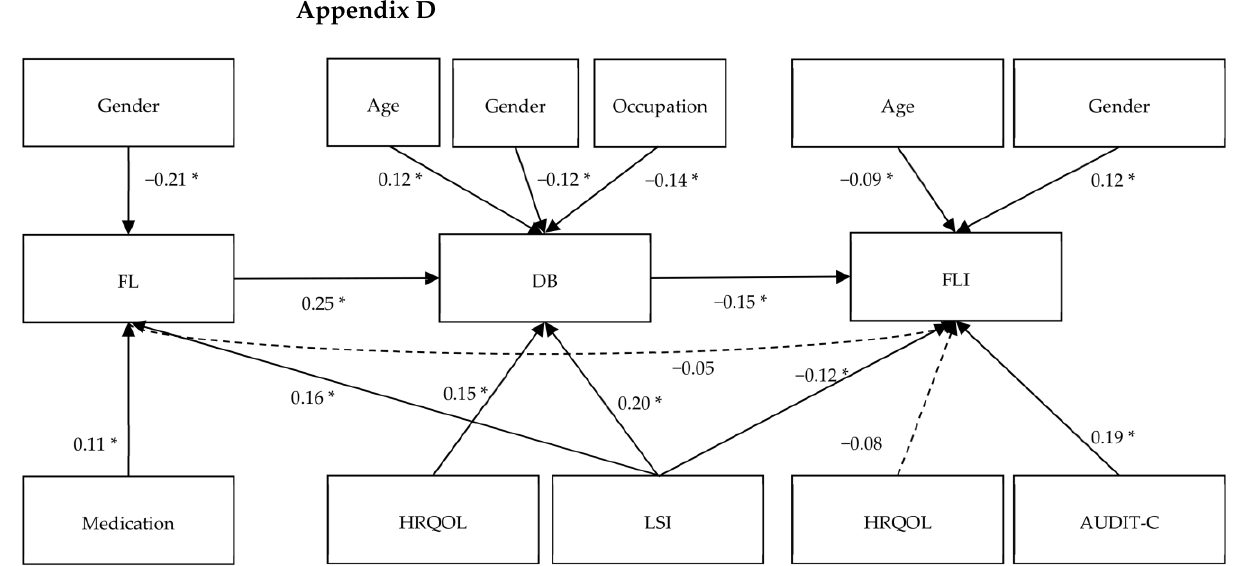
Figure A1. Complete path analysis with standardized path coefficients for the variables. Note: * p < 0.05, N = 372, FL = food literacy, DB = dietary behavior, HRQOL = health-related quality of life, FLI = fatty-liver index, LSI = Leisure Score Index, AUDIT-C = Alcohol Use Disorders Identification Test Consumption. Reference group for gender is female and for occupation white-collar workers, insignificant connections displayed via dashed arrows.